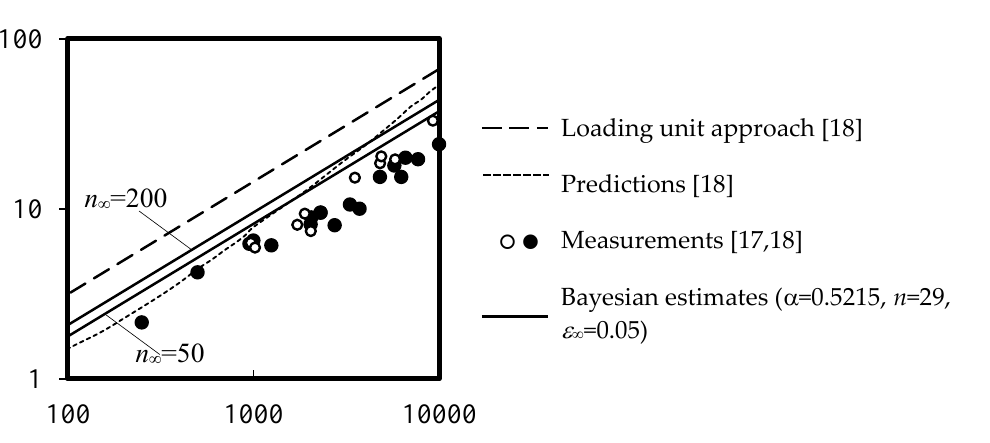
Figure 6. Posterior error estimates. ( a ) α m = 0.4; ( b ) α m = 0.5; ( c ) α m = 0.6; and ( d ) α m = 0.7. x -axis: sample size n . y -axis: error ε (%).